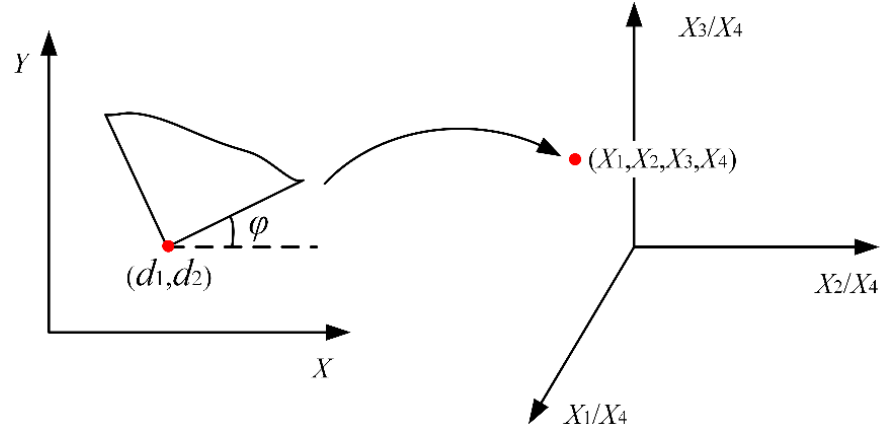
Figure 1. Diagram of kinematic mapping.